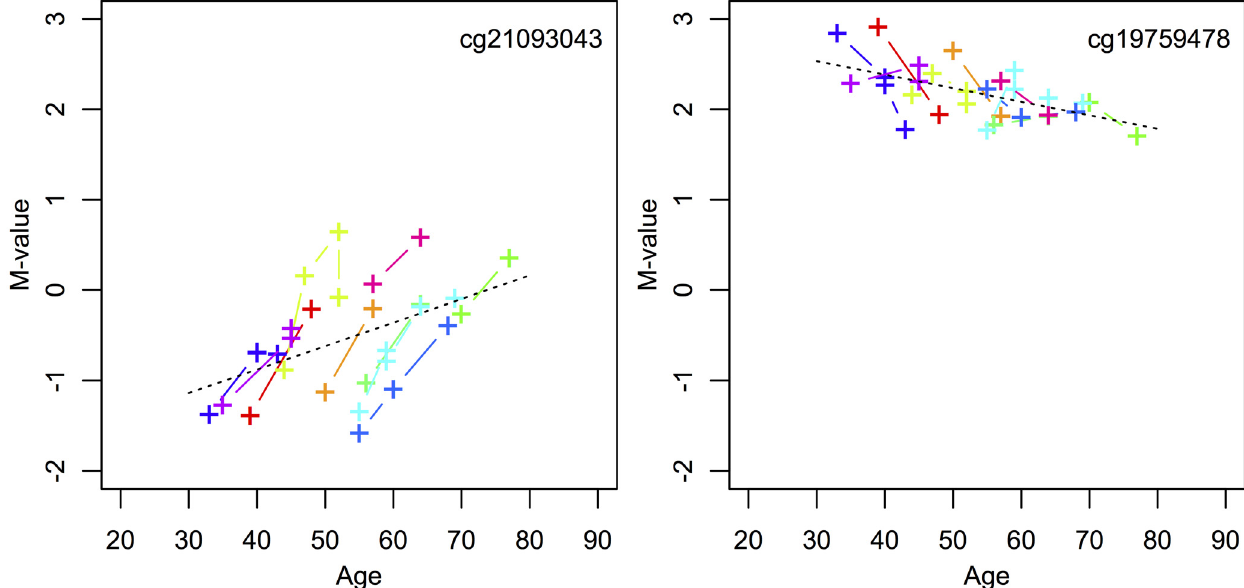
Fig 1. Longitudinal drift from set D1. Examples of one CpG (cg21093043) that significantly drifts up (left panel, becomes increasingly hypermethylated) and one CpG (cg19759478) that significantly drifts down (right panel, becomes increasingly hypomethylated) among longitudinal data points (See Step 1 of Material and Methods). Each individual from data set D1 provides serial samples denoted by color. To illustrate significant population drift across all serial samples for these two CpGs, the black dotted lines show the aggregate regression lines across all samples for cg21093043 (p-value = .005) and cg19759478 (p-value =